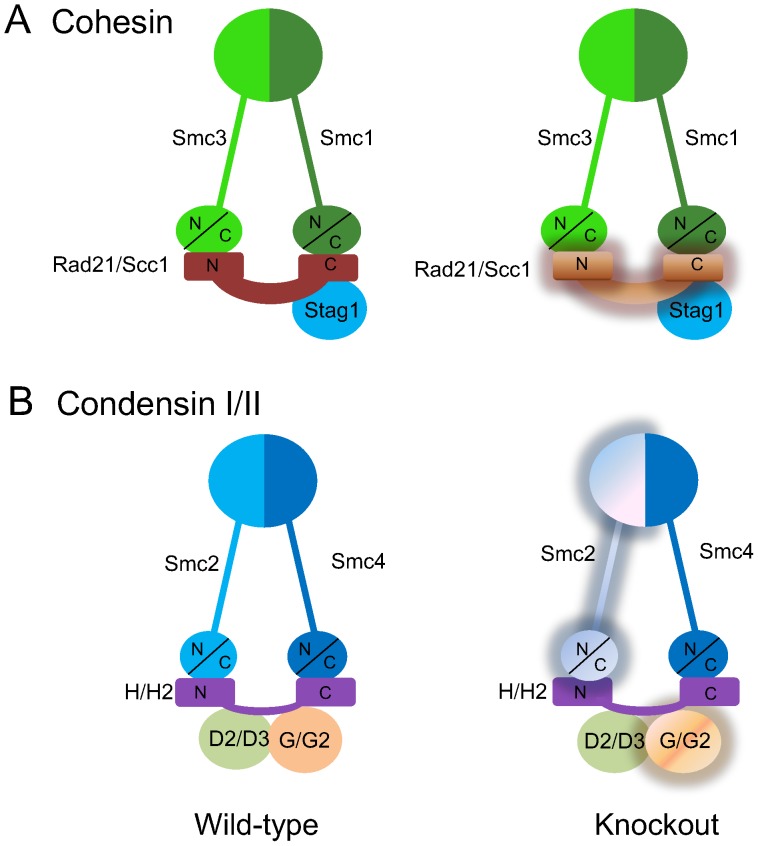
Cohesin/condensin contain structural maintenance of chromosomes (Smc) family of chromosomal ATPases, and non-Smc participants.In Hltf null brain, the functional architecture of each complex is jeopardized by reduced availability (pale shading) of transcripts for major protein components. Panel A, Two twisted Smc proteins (Smc1 and Smc3) that generate V-shaped heterodimers via their hinge domains comprise the core of cohesin. The association of the N- and C-termini of Smc1 and Smc3 with Rad21/Scc1, a kleisin family member that controls separation of sister-chromatids, completes the tripartite ring-like structure. Once properly placed, Rad21/Scc1 is joined at its C-terminus by Stag1 (Scc3). Panel B, Smc2 and Smc4 form V-shaped heterodimers via their hinge domains, and Cap-H/H2, kleisin family members, completes the tripartite ring-like structure. In addition to Cap-H, Condensin I has two additional non-Smc subunits (Cap-D2 and Cap-G). In addition to Cap-H2, Condensin II has Cap-D3 and Cap-G2.